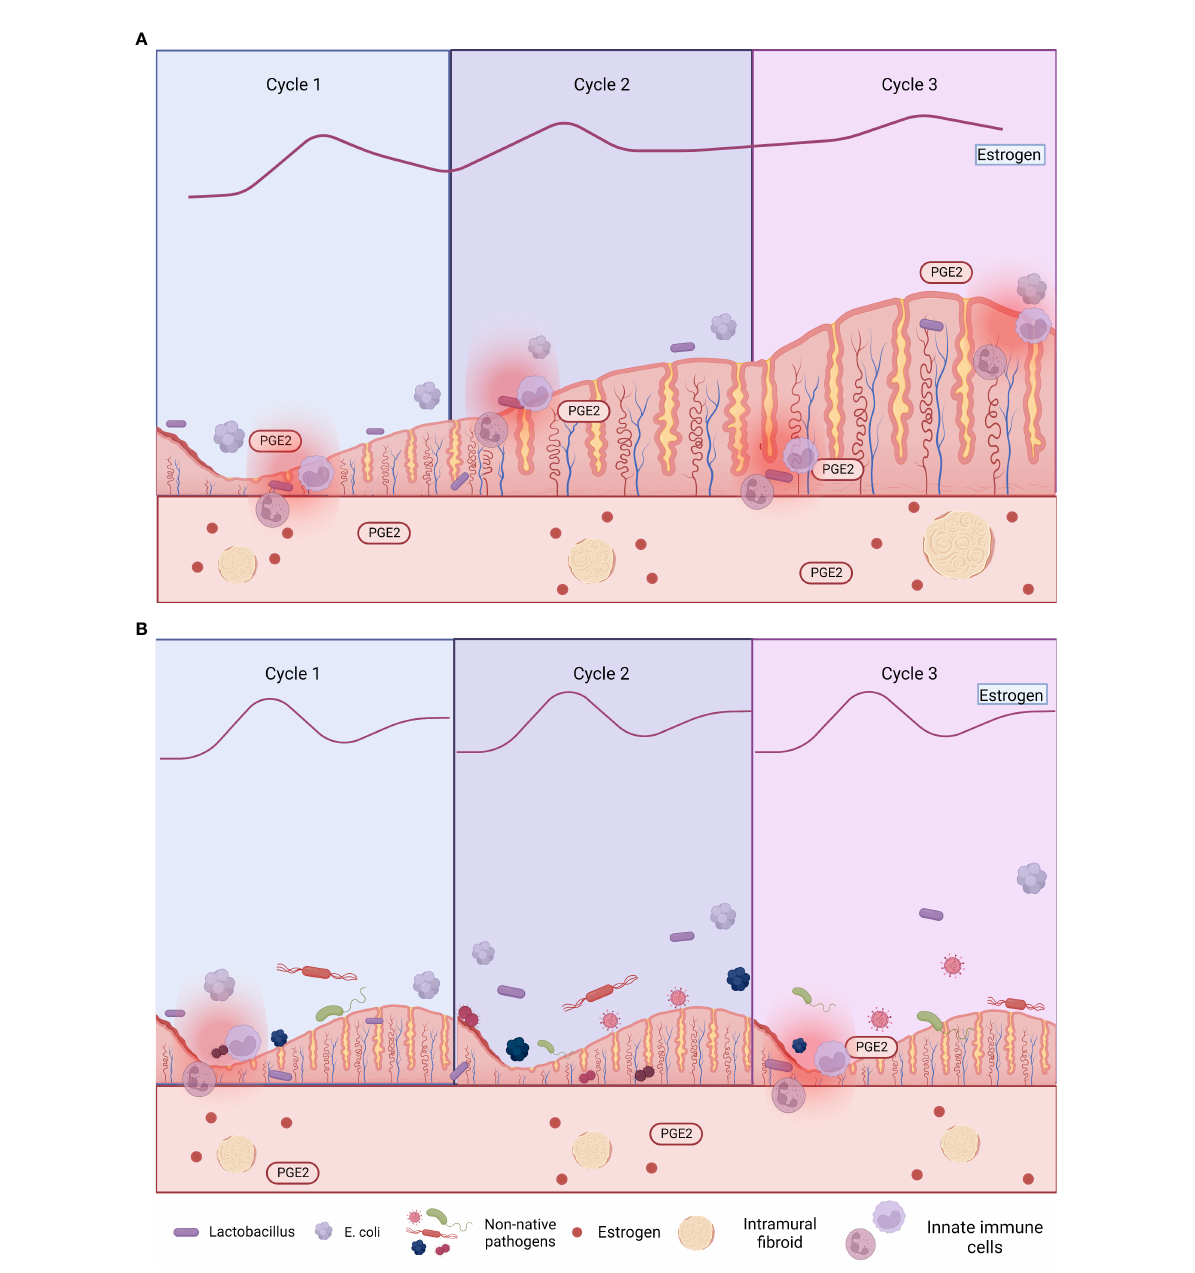
FIGURE 3 Comorbid endometriosis and uterine fi broids that are (A) untreated and (B) treated with gonadotropin-releasing hormone agonist (GnRHa). Excess estrogen exposure is associated with both endometriosis and uterine fi broids (UFs), so estrogen is a target of multiple treatments (e.g., GnRHa and aromatase inhibitors). However, these treatments have local immunosuppressive effects, increasing susceptibility to uterine dysbiosis and subsequent endometriosis (Khan et al., 2014; Qu et al., 2021). Figures are created using